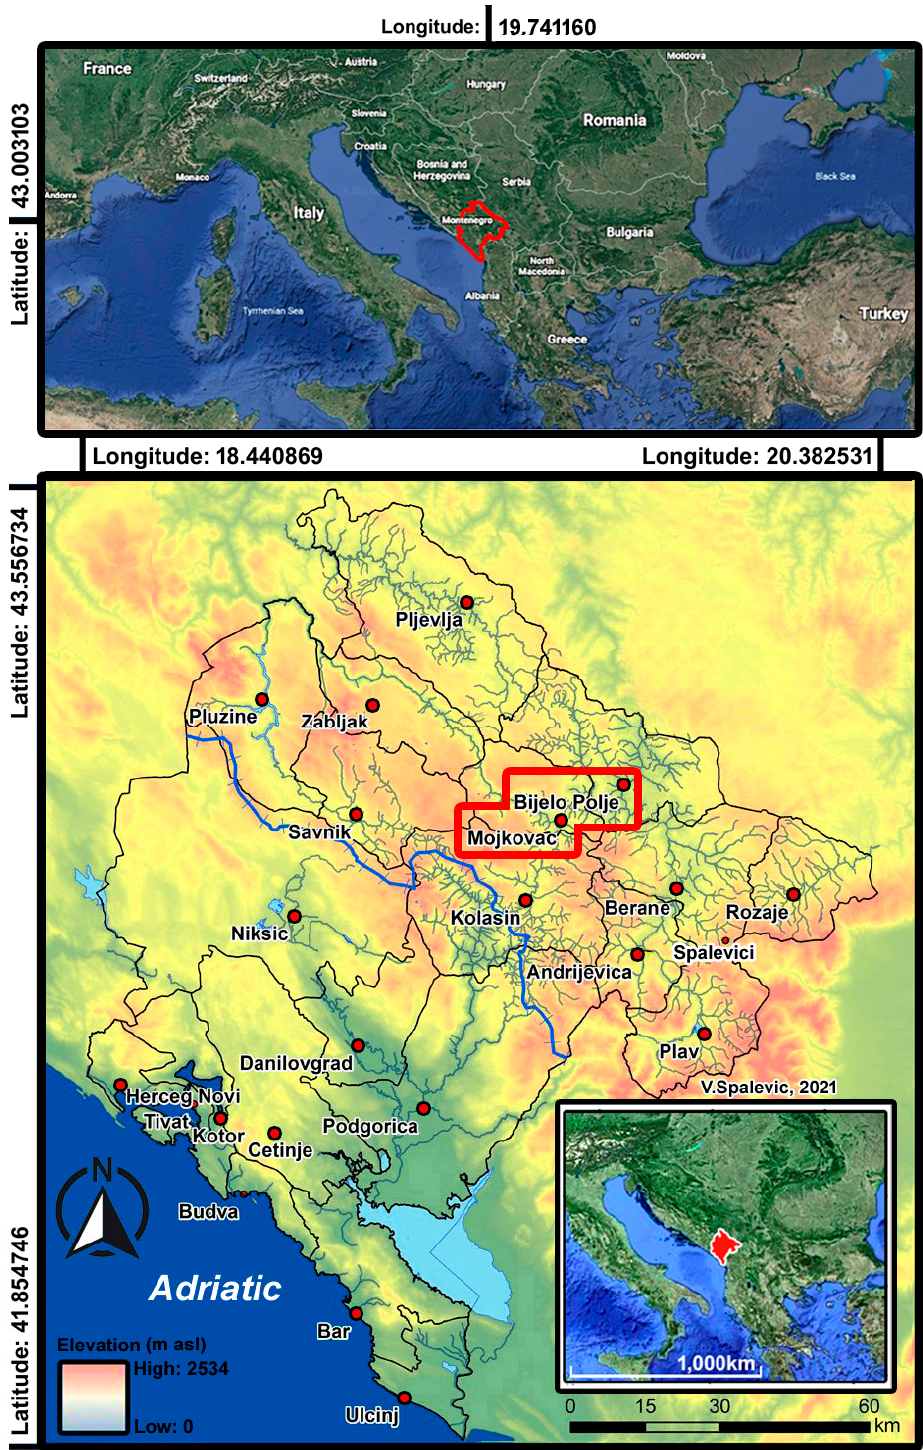
Figure 1. Position of the study areas: Bijelo Polje and Mojkovac, Montenegro.